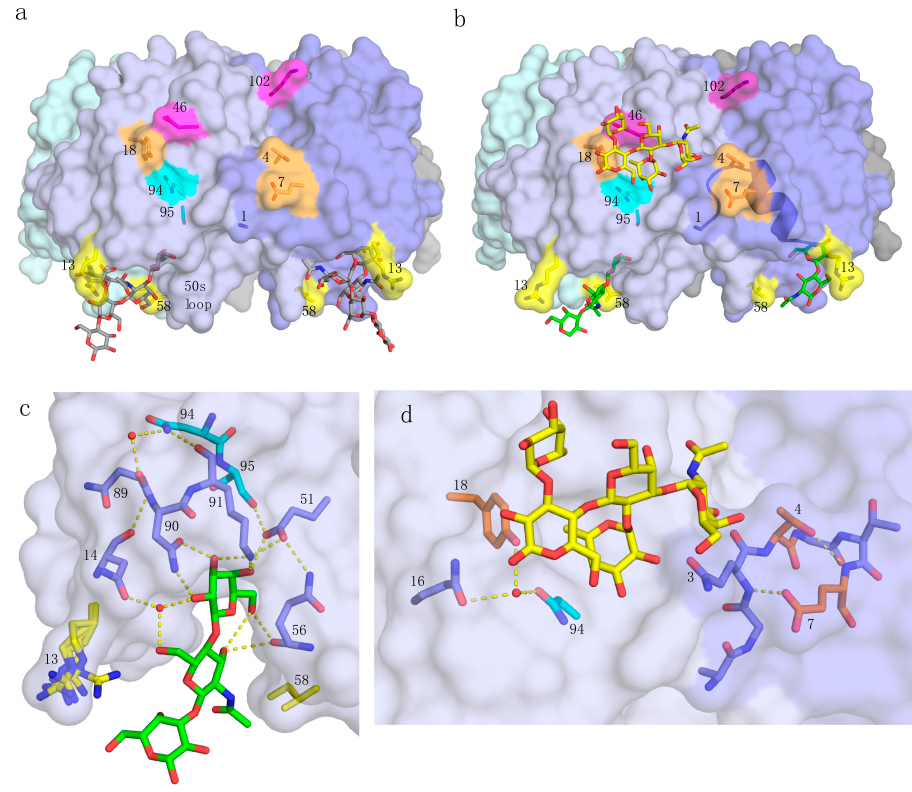
Figure 1. pLTB structure and interactions. Residues and features of special importance for this work are marked, with residues colored in groups, as discussed in Section 2. ( a ) pLTB (PDB ID: 2XRQ [10]) shown in surface representation, colored by subunit. The GM1 oligosaccharide is shown in stick representation, with grey carbons. ( b ) pLTB in complex with lacto- N -neotetraose (LNnT; PDB ID: 2XRS [10]), in a collage with an analogue of the blood group A-pentasaccharide bound to the secondary binding site, superimposed from hLTB structure 2O2L [19]. Not all of the carbohydrate residues were modeled for LNnT, due to weak electron density at the non-reducing end. The α -helix connecting residues 1 through 14 is shown in cartoon representation. ( c ) Close-up view of the primary binding site of pLTB with LNnT (PDB ID: 2XRS [10]). Important residues are shown in stick representation, and the hydrogen-bonding network in yellow dotted lines, extending up to residue 94 (cyan). Two conserved water molecules are depicted as red spheres. Residue 13 (yellow) adopts alternative conformations in the different subunits, and residue 58 (yellow) has van der Waals contacts to the methyl group of GlcNAc. ( d ) Close-up view of relevant residues at the secondary binding site of pLTB (PDB ID: 2XRS [10]), with the A-pentasaccharide (from PDB ID: 2O2L [19]) superimposed in yellow sticks. Important residues on both sides of the secondary binding site are